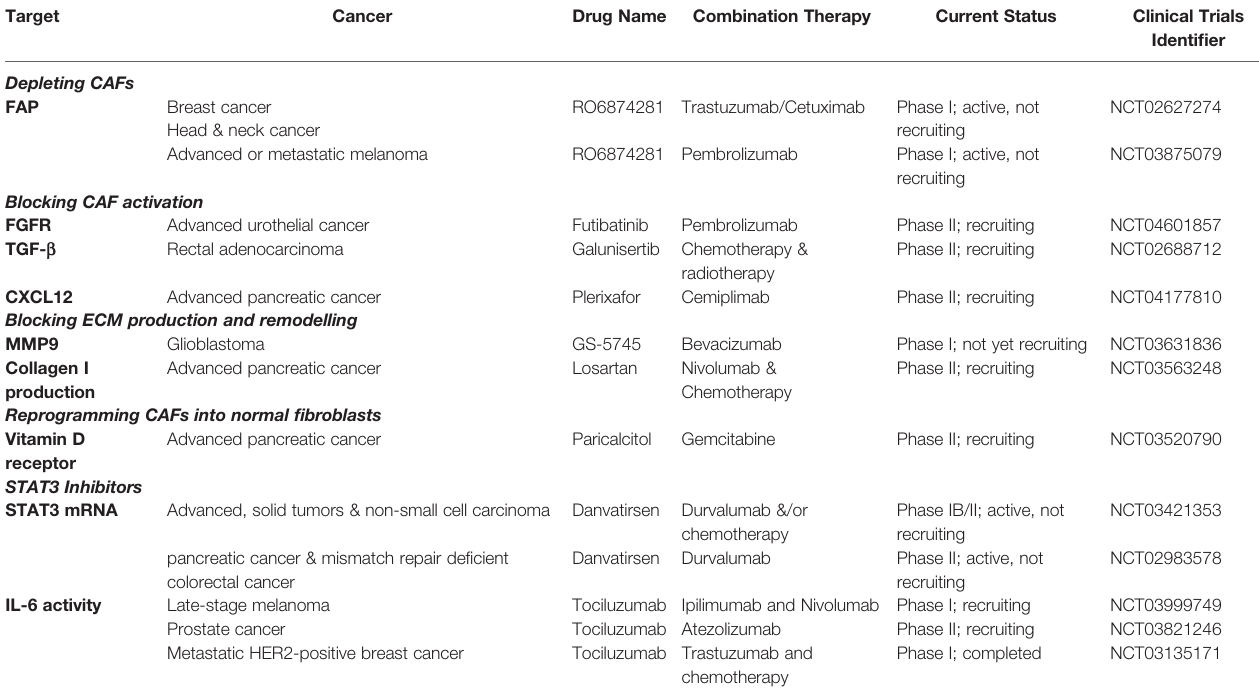
TABLE 1 | Clinical trials targeting CAFs and STAT3 in